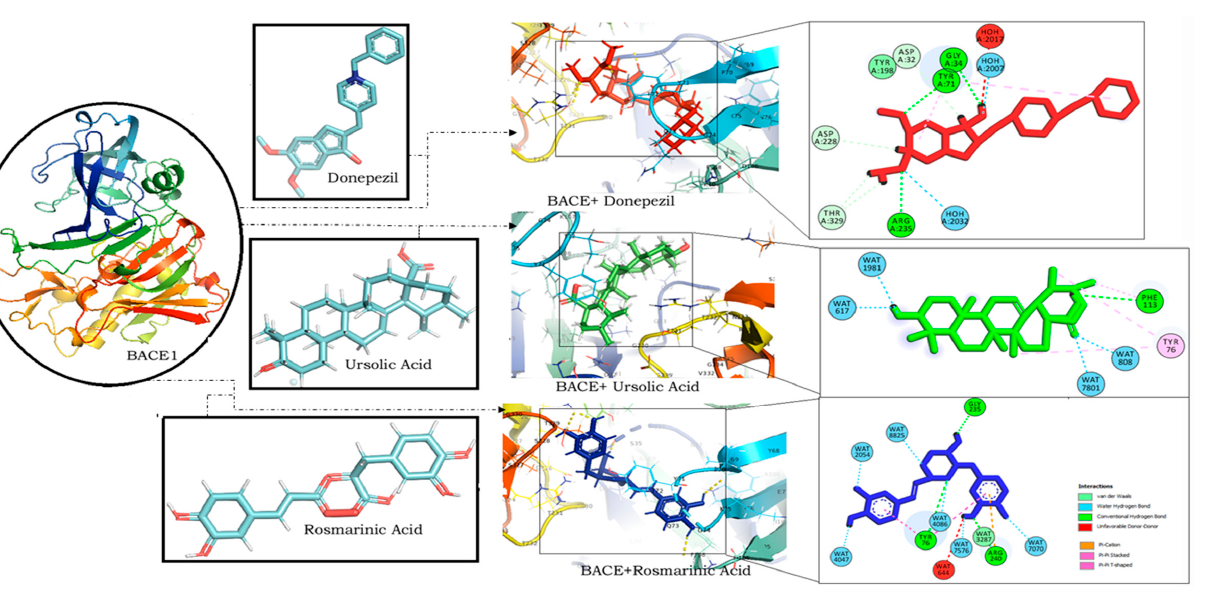
Figure 2. Molecular docking interaction models of AChE (PDB ID: 4PQE) with donepezil and ursolic acid. 2D structures of the compounds are shown by line and stick models with the surrounding amino acids of AChE. The interactions are denoted by the following colors: hydrogen bonding interactions (green), alkyl bonds (pink) and bumps (red). AChE; Acetylcholinesterase. 2.1.2. RA Exhibits Strong Binding Interactions Strikingly Similar to Donepezil with BACE1 RA was found to have the lowest binding energy in comparison to CA (Binding energy: − 5.85) and UA (binding energy: − 5.48) in interaction studies with BACE1. With a binding energy of − 7.45, it exhibited a strong binding potential comparable to that of donepezil (binding energy: − 8.27) (Table 1). It also bound to similar residues and at the same binding site as that of donepezil (Figure 3).